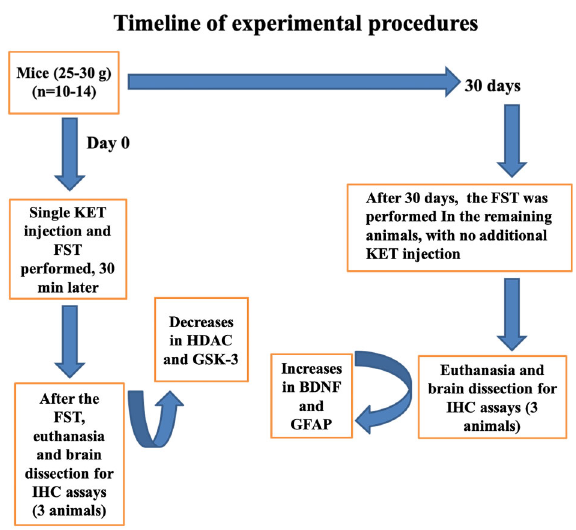
Figure 1. Study timeline. KET: ketamine; FST: forced swim test; IHC: immunohistochemistry; BDNF: brain derived neurotrophic factor; GFAP: glial fi brillary acidic protein;GSK-3: glycogen synthase kinase; HDAC: histone